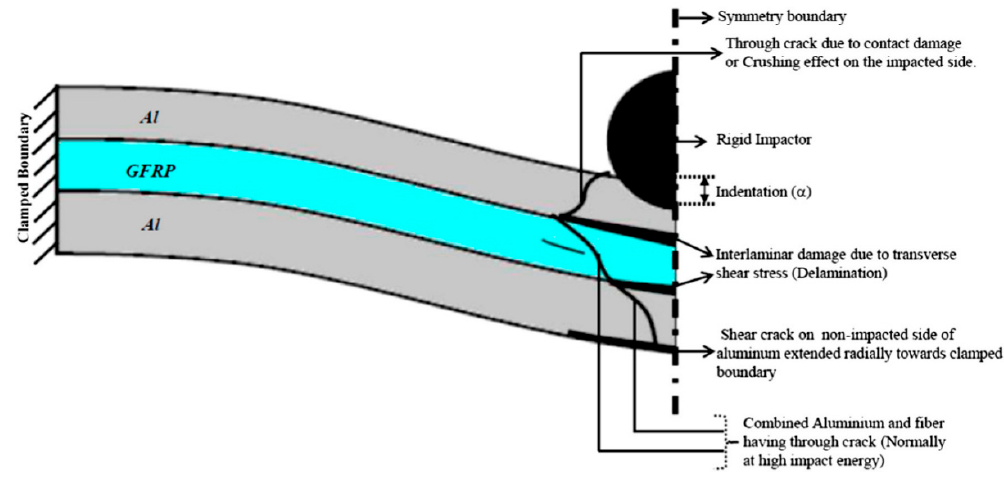
Figure 3. Possible failure modes in clamped CCFR-MIL plate during low-velocity impact test.